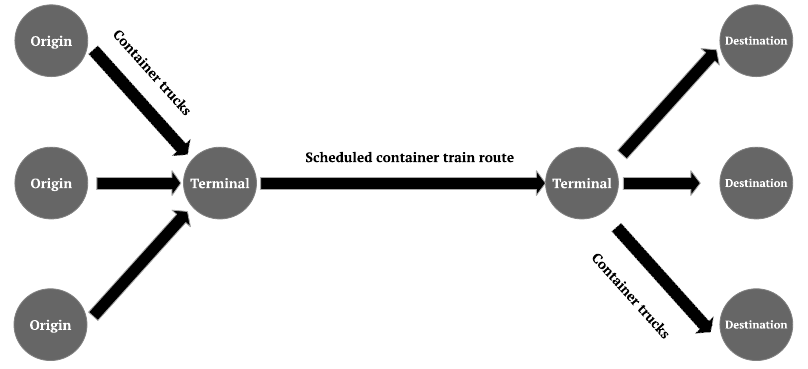
Figure 7. Road-rail intermodal hub-and-spoke transportation network.